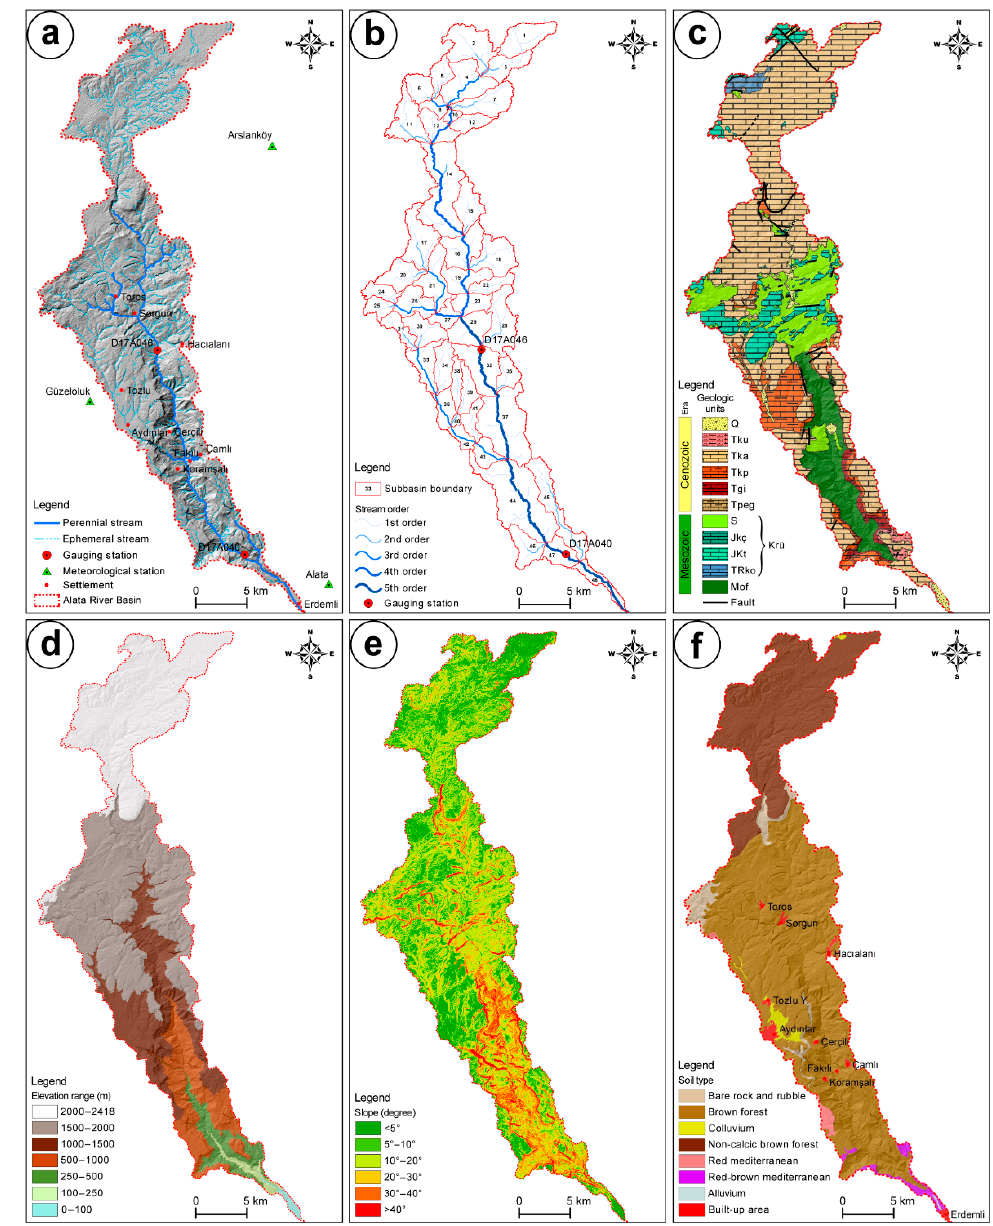
Figure 2. Maps showing ( a ) the river and hydro-meteorological monitoring networks; ( b ) GIS-derived subbasin boundaries ( n = 48) and the river network; ( c ) subsurface geology (abbreviations: Q = quaternary unconsolidated sediments, Tku = Kuzgun fm., Tka = Karaisalı fm., Tkp = Kaplankaya fm., Tgi = Gildirli fm., Tpeg = Güzeller fm., Krü = Mersin ophiolitic mélange (S = Serpentinite, Jkç = Çaml ı k fm., Jkt = Tav ş anc ı da ğ Tepe fm., TRko = Kocatepe fm. and Mof = Mersin ophiolite) and the major tectonic structures (modified from [53,54]); ( d ) digital elevation model (DEM) with a grid size of 15 m; ( e ) slope map; and ( f ) the major soil types (adapted from [55]) of the Alata River Basin (ARB).